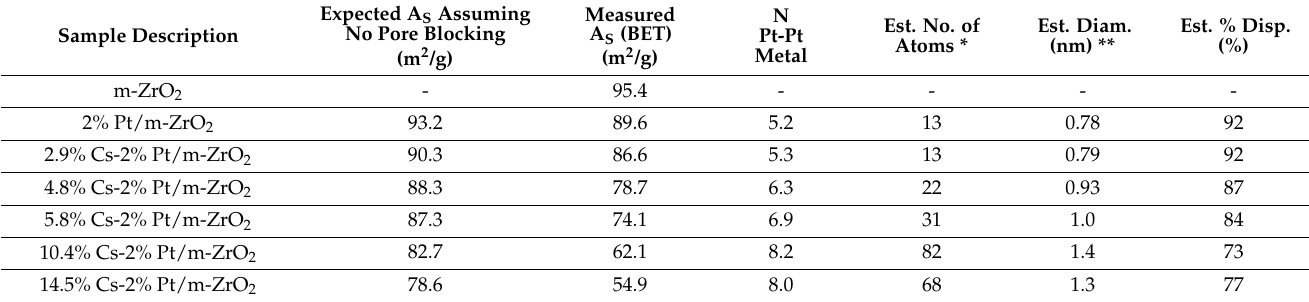
Table 1. Summary of BET surface area and Pt particle size (adapted from [20] with permission from Catalysts, MDPI). Sample